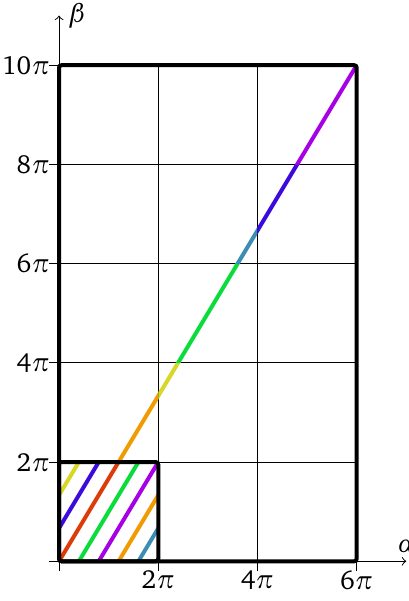
Figure 6: Periodic motion on a torus, with rational winding p / q , may be seen as the projection of a tra- jectory with unit winding on a pq -fold larger